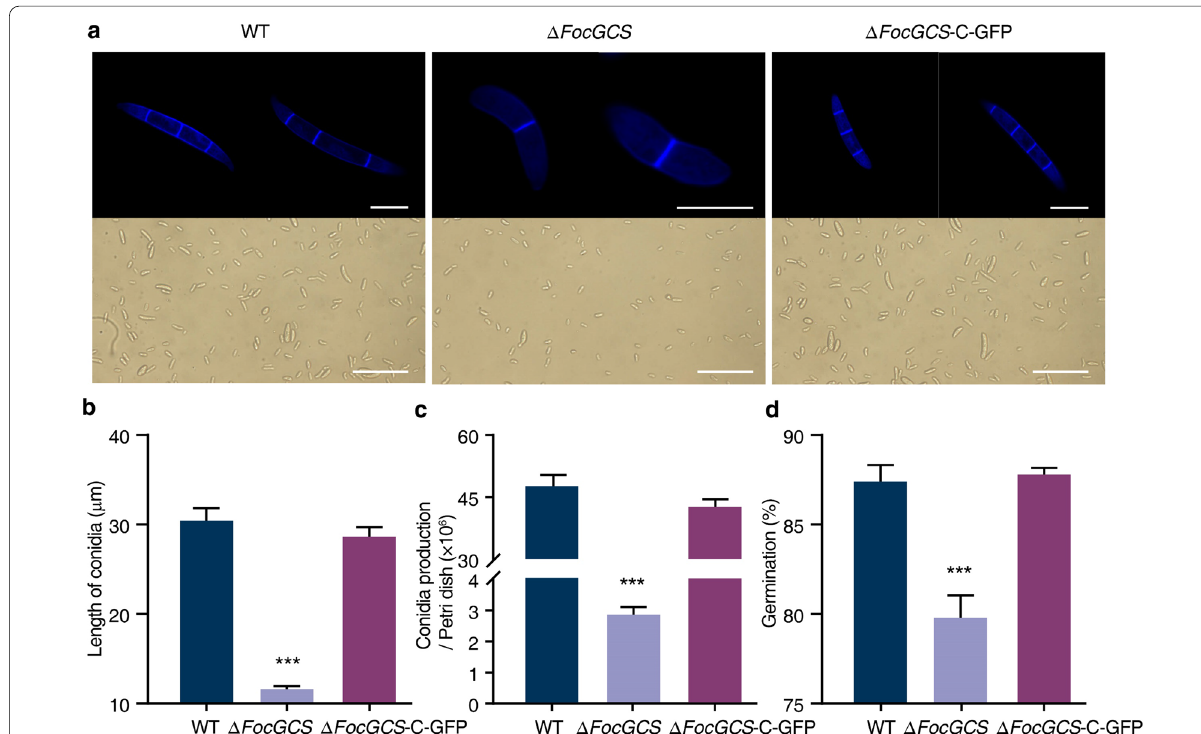
Fig. 3 Targeted disruption of FocGCS affects conidiation, conidial germination, and conidial morphology of Fusarium oxysporum f. sp. cubense tropical race 4. a Conidial morphology of the WT, ∆ FocGCS , and complemented strains. Blue fluorescence represents the number of fungal septa. Scale bars 10 μm (upper) and 100 μm (bottom). b Conidial length examined by counting of at least 100 randomly selected conidia per three = microscopy fields. The mean values SD were calculated from three independent experiments. c Conidia production of the indicated strains ± incubated for 5 days on PDA plates. d Conidial germination rate of the strains incubated on YEPD broth for 12 h. Germination of 100 conidia was randomly examined. Asterisks indicate significant differences from the WT group (Student’s t ‑test, *** P <